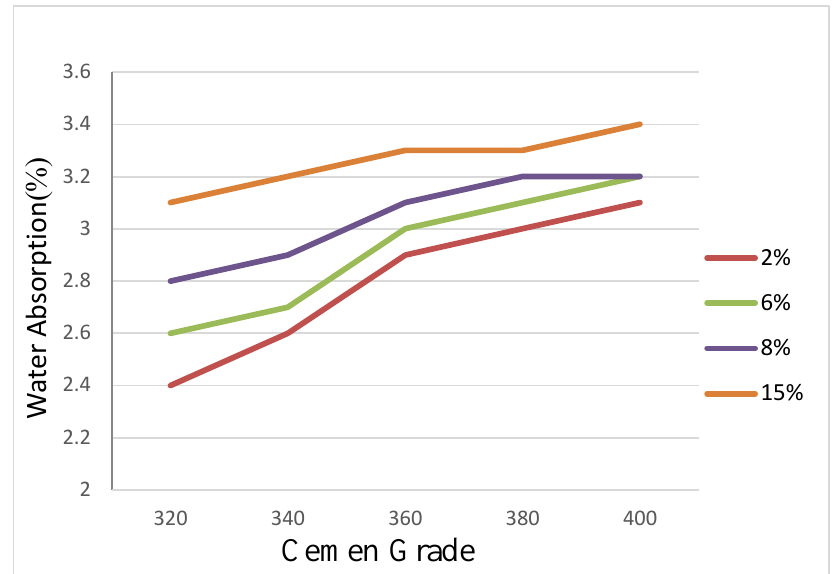
Fig. 13. Diagram of water absorption percentage of concrete containing abiotic Zeolite to cement